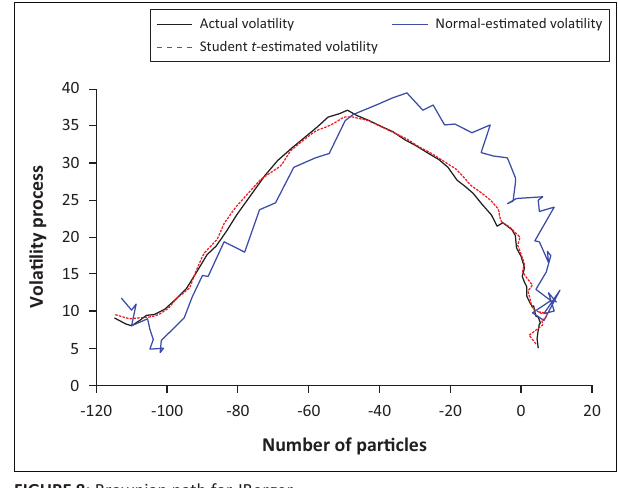
FIGURE 8: Brownian path for JBerger.